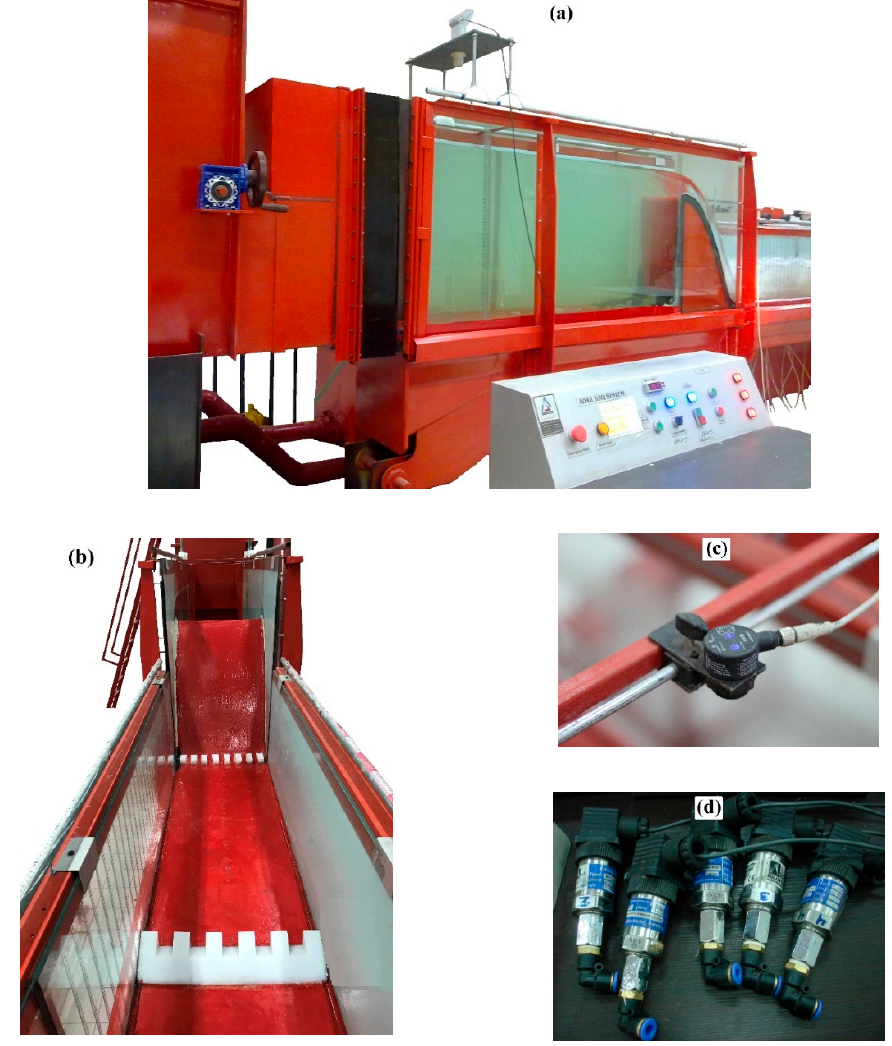
Figure 1. Laboratory flume and experimental setup . ( a ) Hydraulic jump during an experiment, ( b ) basin II with chute blocks and dentated end sill, ( c ) Data logic ultrasonic sensor device model US30, and ( d ) pressure transducers (Atek BCT 110 series with 100 mbar-A-G1/4 model).